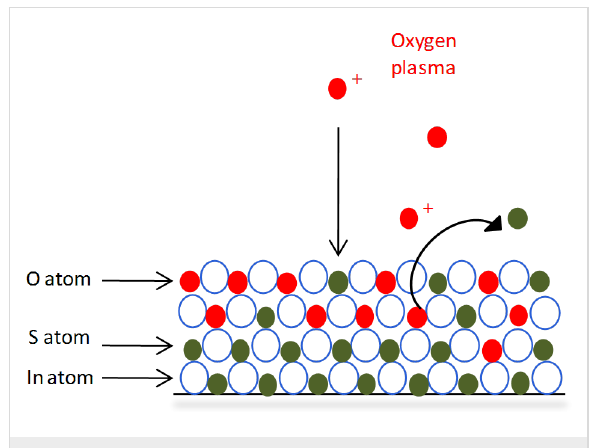
Figure 7: Surface mechanisms during the O 2 plasma